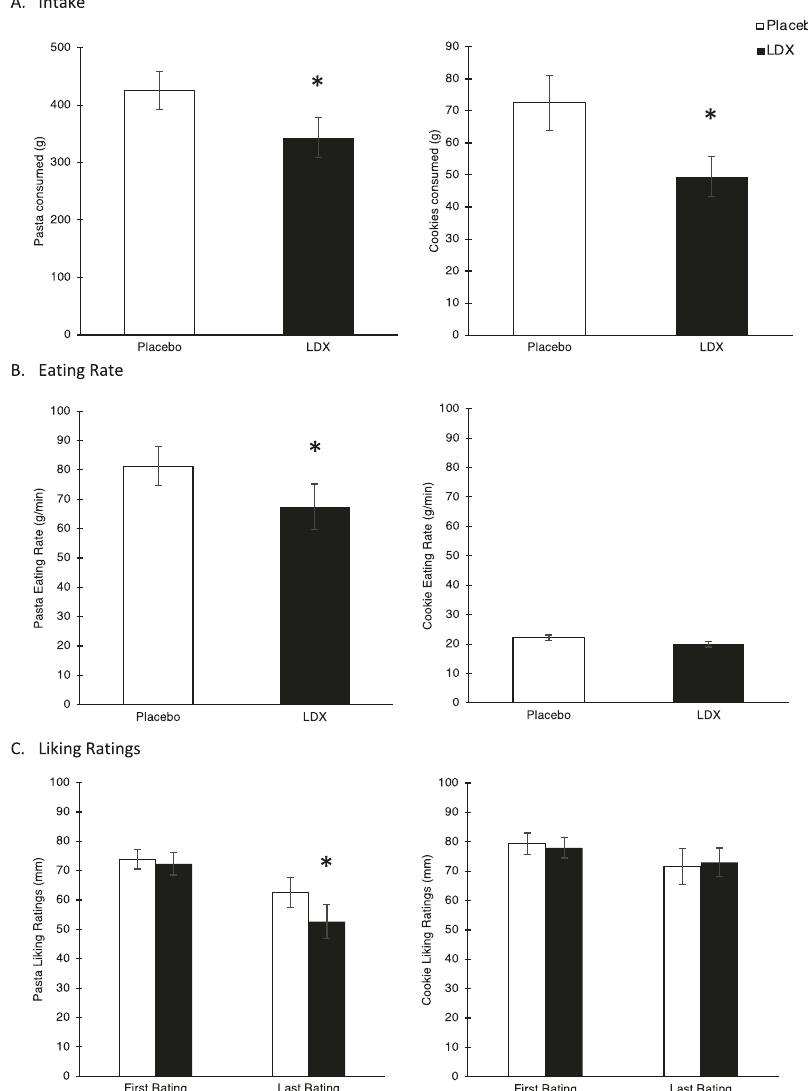
Fig. 2 Eating-related measures. A Intake of pasta and cookies for the placebo (open bars) and LDX ( fi lled bars) conditions. B Eating rate of pasta and cookies for the placebo (open bars) and LDX ( fi lled bars) conditions. C Liking ratings of pasta and cookies for the placebo (open bars) and LDX ( fi lled bars) conditions. Error bars represent standard error of the mean. Asterisk denotes signi fi cantly different from placebo ( p < 0.05).